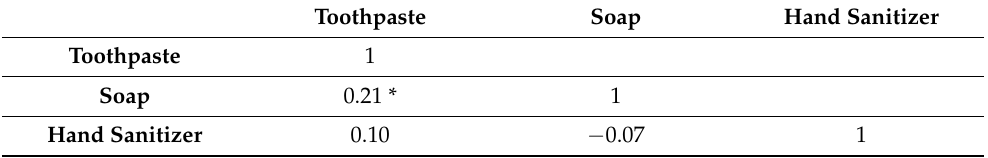
Table 7. Pairwise correlation matrix for the average net price. Soap is Method body wash. * p < 0.01.